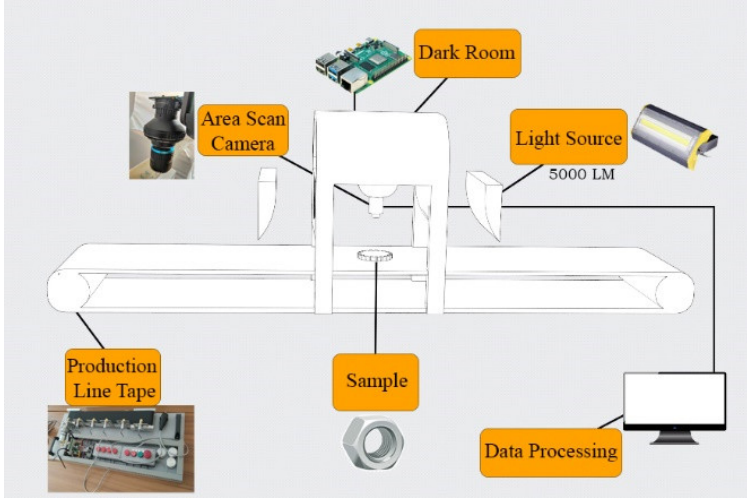
Figure 5. Principle of the system.